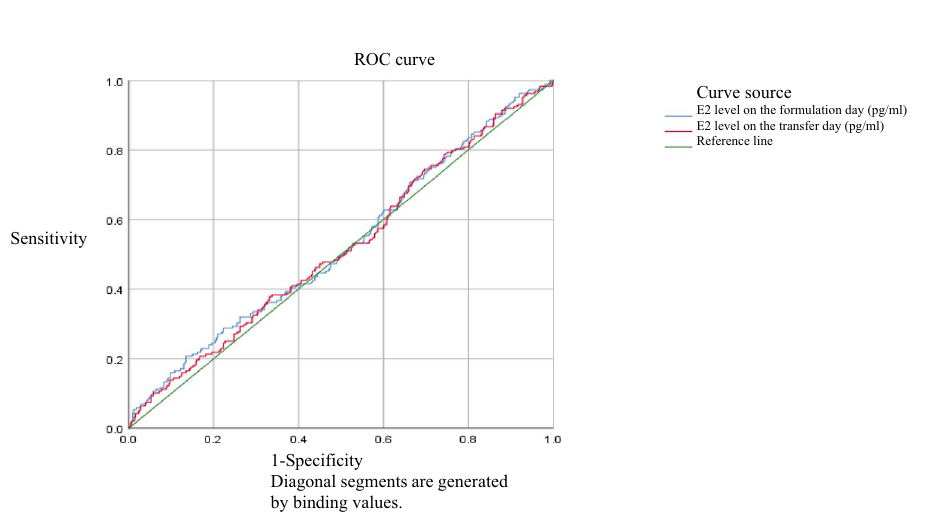
Figure 1. Correlation analysis between clinical pregnancy and serum E2